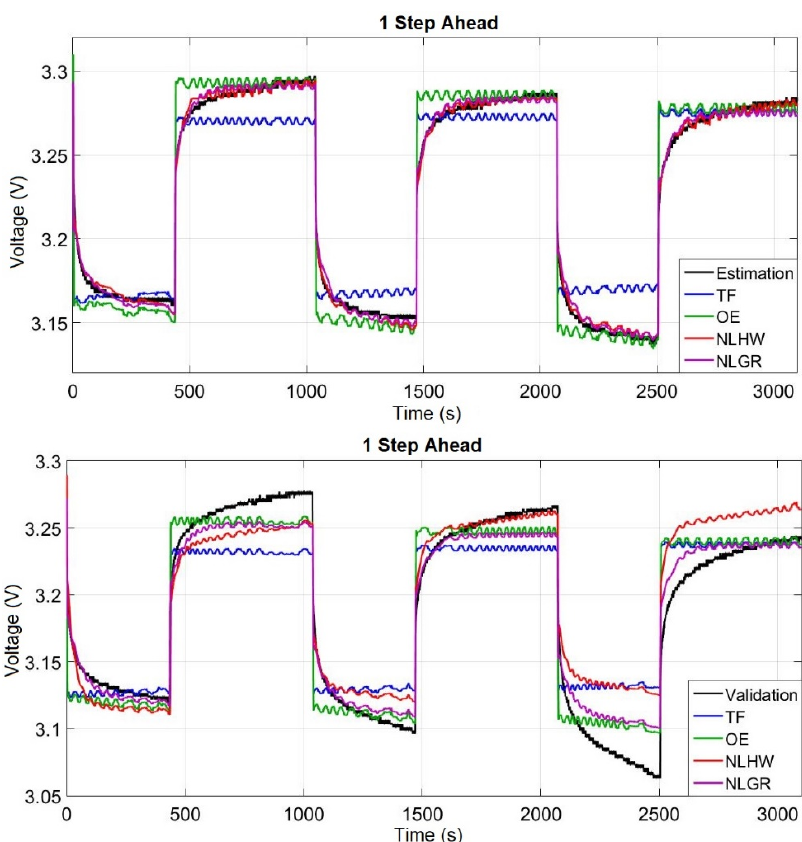
Figure 8. One-step ahead prediction with estimation data and validation data.